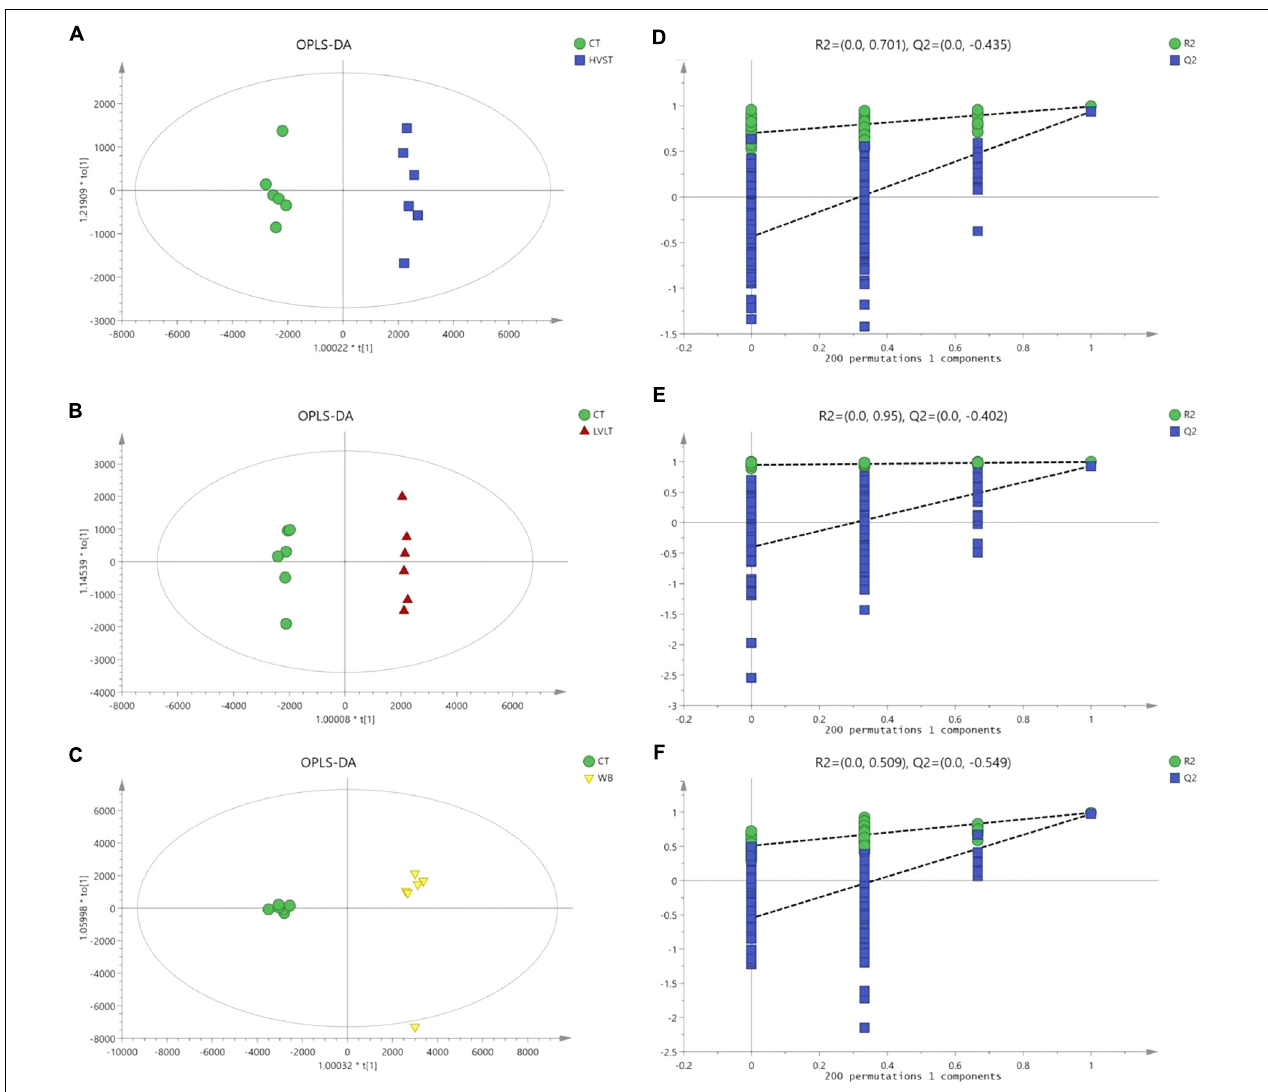
FIGURE 2 | OPLS-DA modeling of metabolites from E. coli O157:H7 cells. S-plots (A–C) showed the analysis of datasets for HVST vs. CT, LVLT vs. CT, and WB vs. CT treated samples, respectively. t[1] was the first principal component (predicted principal component), and to[1] was the second principal component (orthogonal principal component). (D–F) Permutation testing confirmed the good quality of each